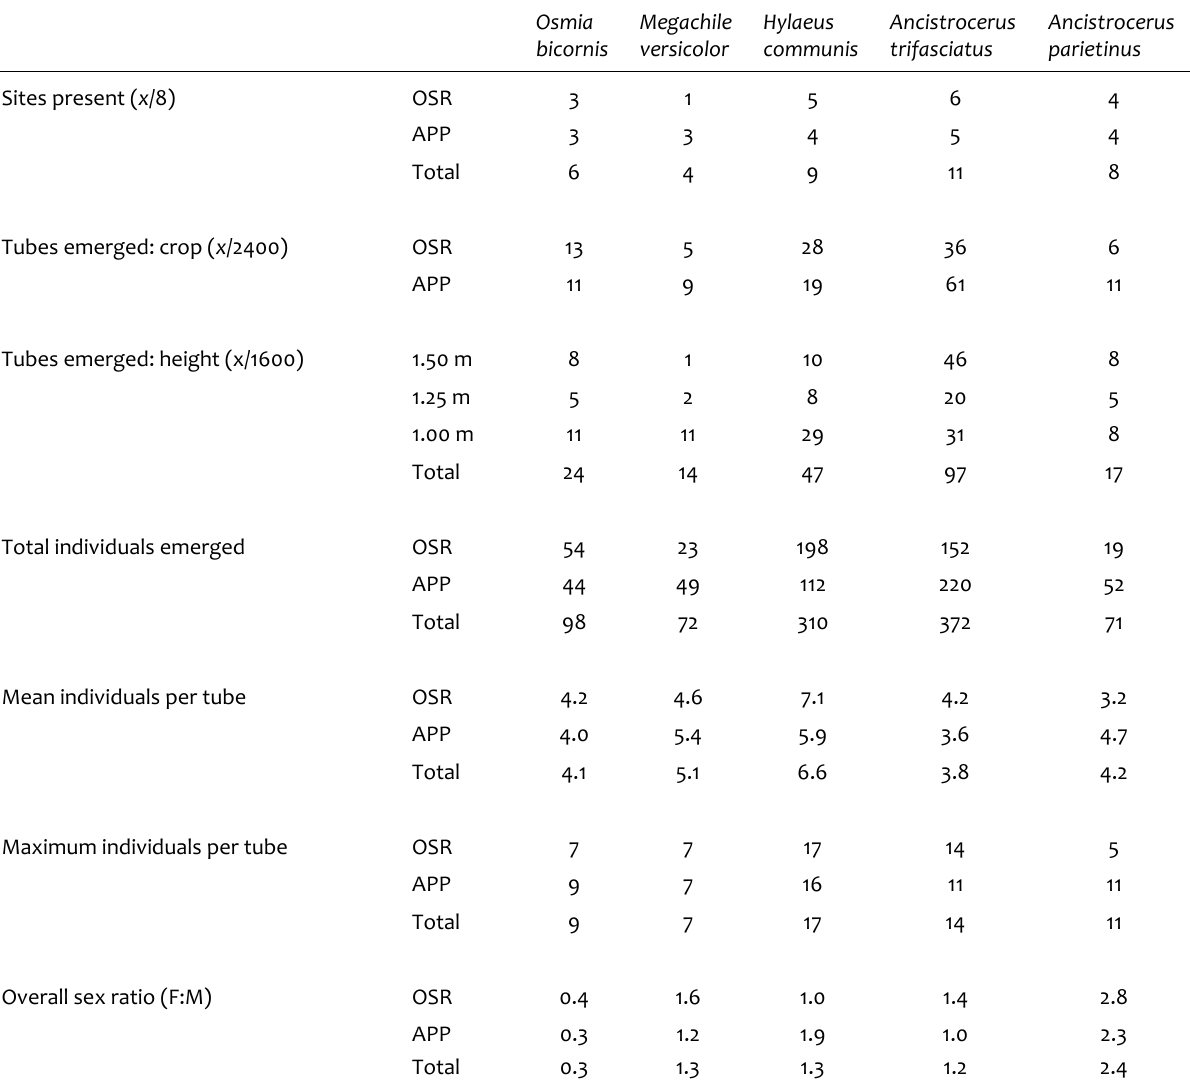
Table 2. Summary of emergence data for five species of stem-nesting Hymenoptera from trap nests set at three different heights in eight oil seed rape (OSR) and eight apple (APP) sites in